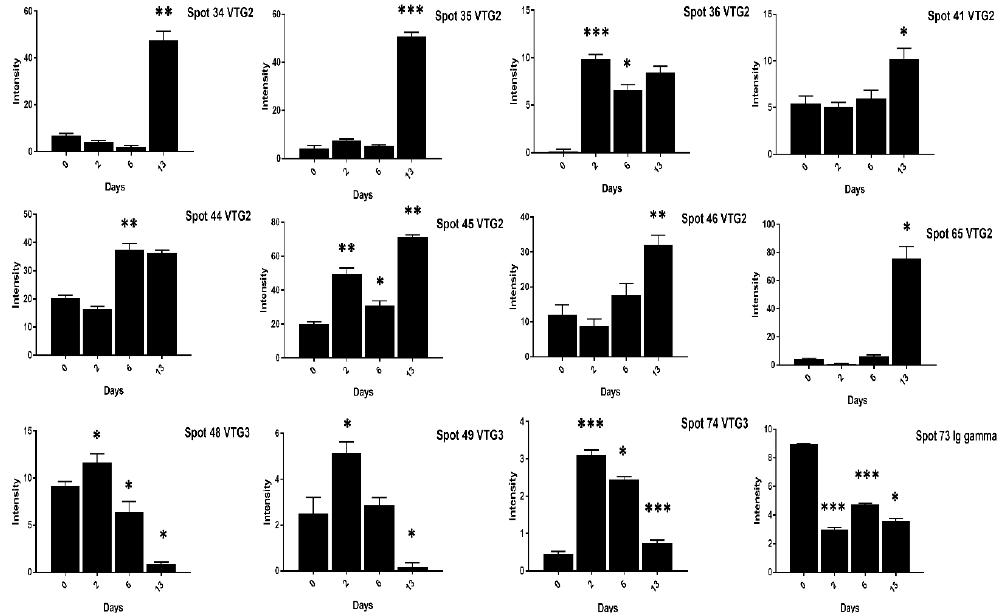
Figure 4. The changes in the intensity of egg yolk proteins at 0, 2, 6, and 13 days of incubation are shown in high cholesterol eggs. The column profiles of VTG-2 spots (34–36, 41, 44–46, 65) and VTG-3 spots (48, 49, 74) Ig gamma (73) are shown as bar charts with significant differences. The significant differences were determined from the comparison with the control and the asterisks denote statistically significant differences. The data represent the mean values (±SD) from three replicates. * p < 0.05, ** p < 0.005, *** p < 0.0001. Some VTG-2 protein spots (28–31, 34–36, 44–46, 65) showed high expression at two days of incubation in low cholesterol eggs only (Figures 5 and 6).